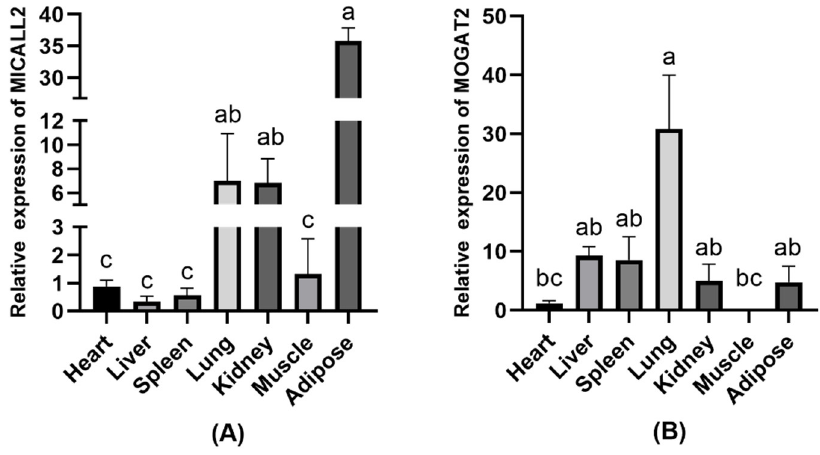
Figure 2. MICALL2 and MOGAT2 expression in Ashidan yak tissue samples. ( A ) MICALL2 and ( B ) MOGAT2 expression levels in different tissues. a–c denote significant differences at p < 0.05.